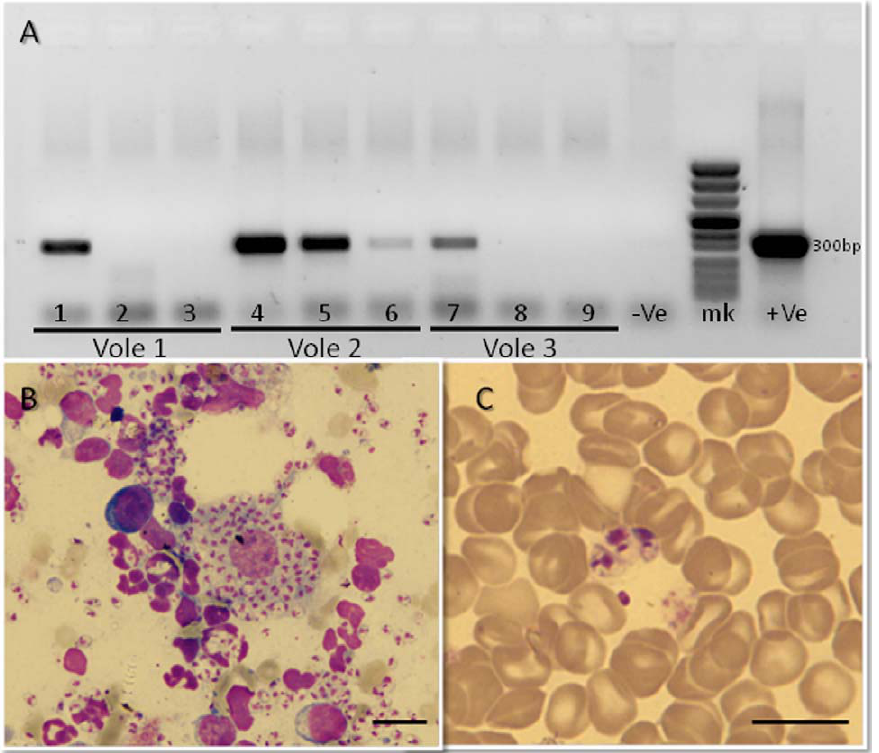
Figure 5. Artificial L.major infections in voles. (A) Leishmania-specific ITS1 PCR products (300 bp) in three voles, three weeks post-inoculation. Lanes 1,4,7 – ears. Lanes 2,5,8 – hind foot pads. Lanes 3,6,9 – snout. Biopsies were taken weekly after inoculation of 10 5 late log -phase L. major promastigotes in each inoculation site. 2 Ve – negative control without DNA, + Ve – positive control containing L. major DNA, mk – marker reference ladder. (B) Micrograph of tissue smear showing amastigotes-laden macrophages from the ear of a vole, six weeks P.I. (C) Blood smear showing free amastigotes. Peripheral blood from the hind foot pad of an infected vole seven weeks P.I. Scale bars=10 m m.